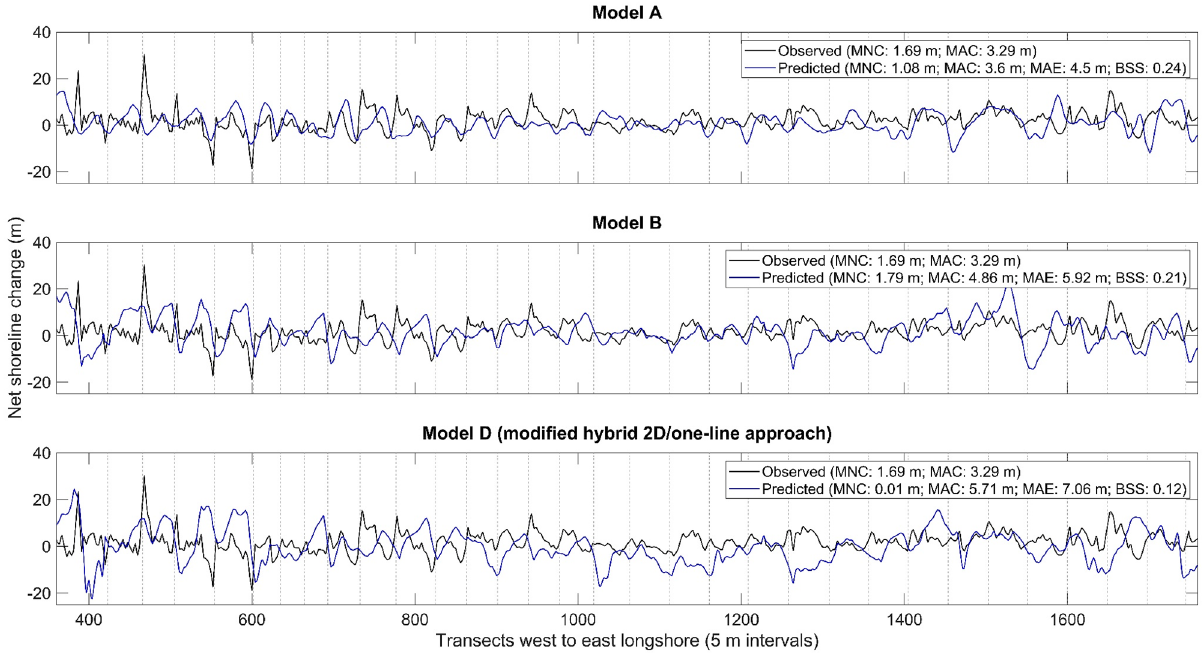
Figure 9. Observations and predictions of shoreline evolution from models A, B, and D (1966–2016). Model A applies the traditional hybrid 2D/one-line approach, assuming a constant closure depth (4.2 m). Model B also adopts the traditional hybrid 2D/one-line approach (closure depth = 6 m) but applies the one-line theory principles in both sediment transport simulations and shoreline morphology update. Model D applies the modified hybrid 2D/one-line approach developed, incorporating temporal variations in the closure depth (range 5.23–7.93 m). MNC is mean net change, MAC is mean absolute change, MAE is mean absolute error, and BSS is Brier Skill Score. Grey vertical dashed lines indicate groyne